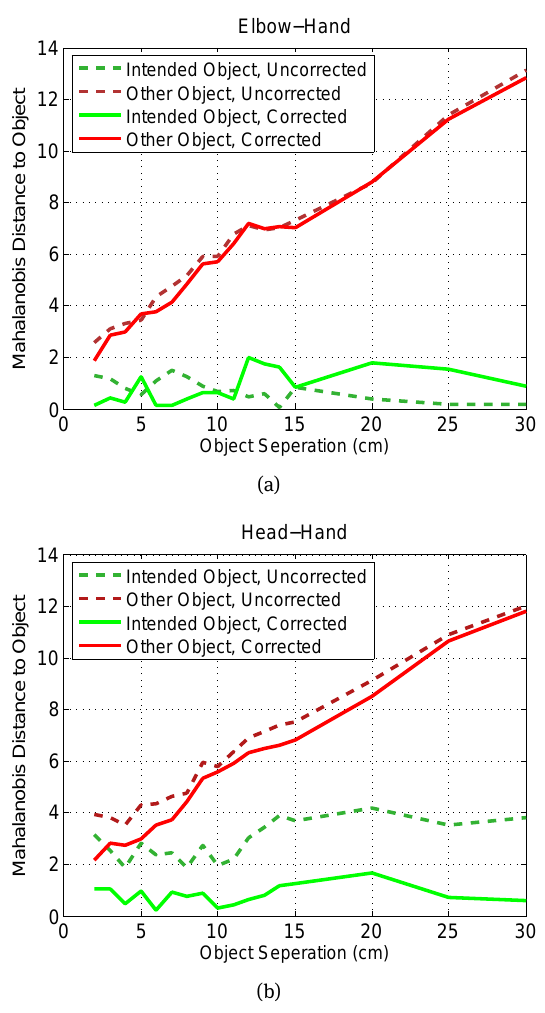
Figure 10: Resulting Mahalanabis distances of pointing targets from the Object Separation Test is shown for a) Elbow-Hand and b) Head- Hand pointing methods. Plots for intended objects are shown in green and for the unintended objects are shown in red. Solid lines show distances after correction is applied. Less Mahalanobis dis- tance for intended object is better for reducing